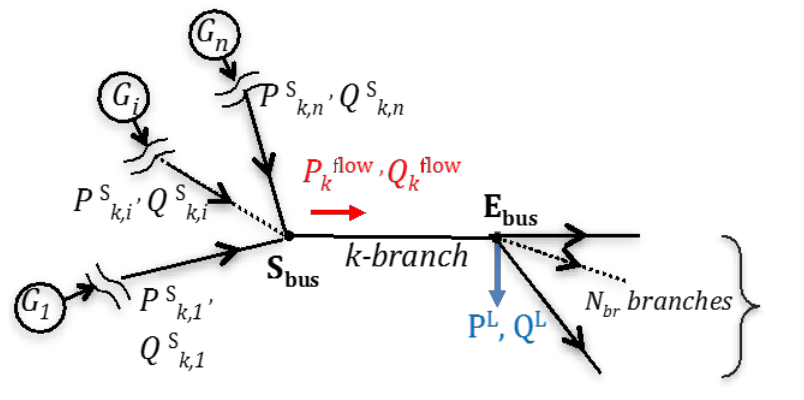
Figure 1. Partition of the power flows among generators in a generic branch